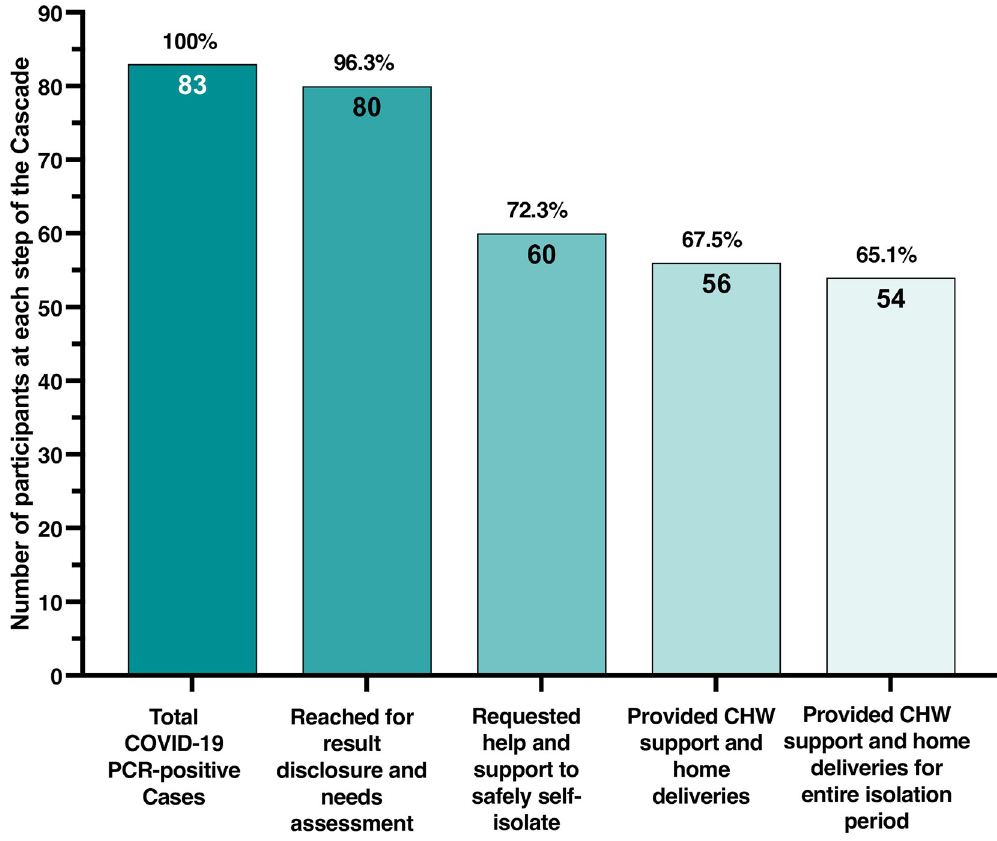
Fig 2. Cascade of enhanced community-based support among COVID-19